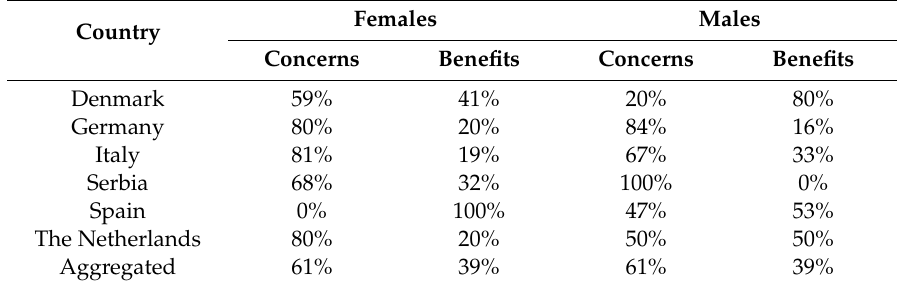
Table 4. Relative frequency (%) of concerns and expected benefits stated by female and male participants in all